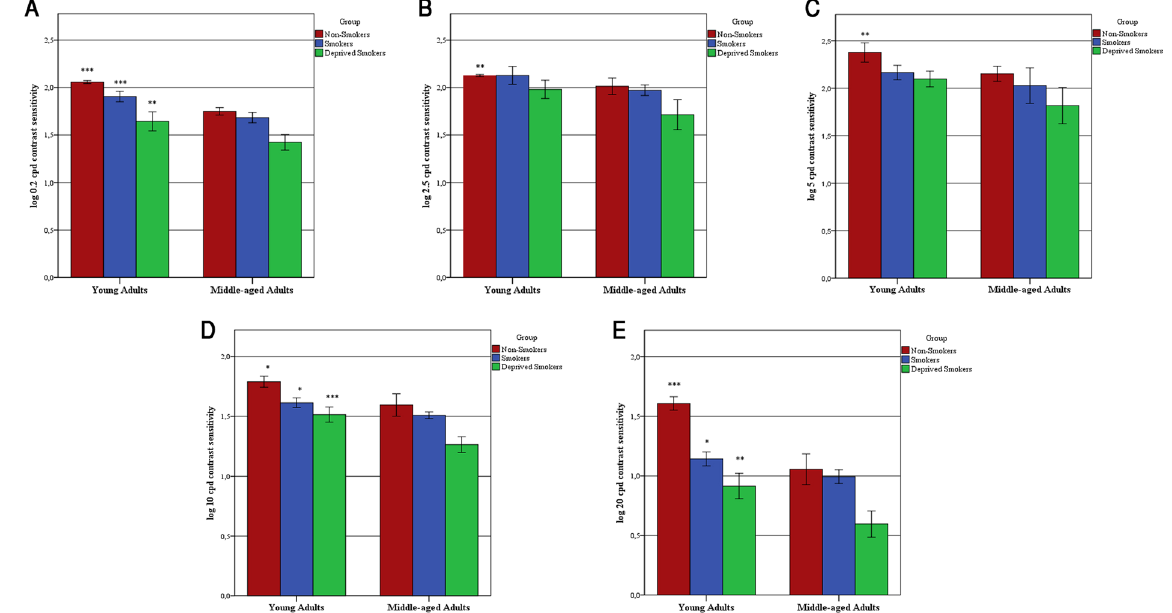
Figure 2. Contrast sensitivity bars as a function of age groups for non-smokers, smokers and deprived smokers at each spatial frequency. Color bars represents the sensitivity (reciprocal of contrast threshold) for each spatial frequency. Error bars represents the standard deviation ( SD ) of the mean sensitivity. *** p < 0.001, ** p < 0.01, * p <